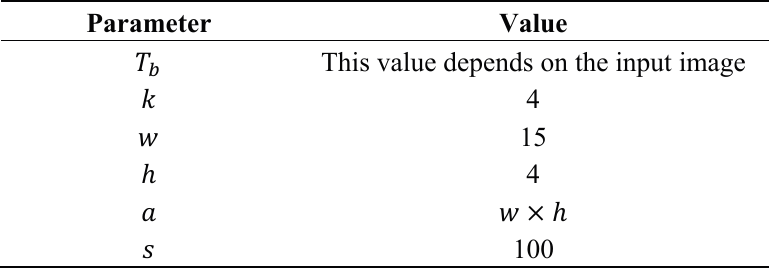
Table 1. Parameters used in this